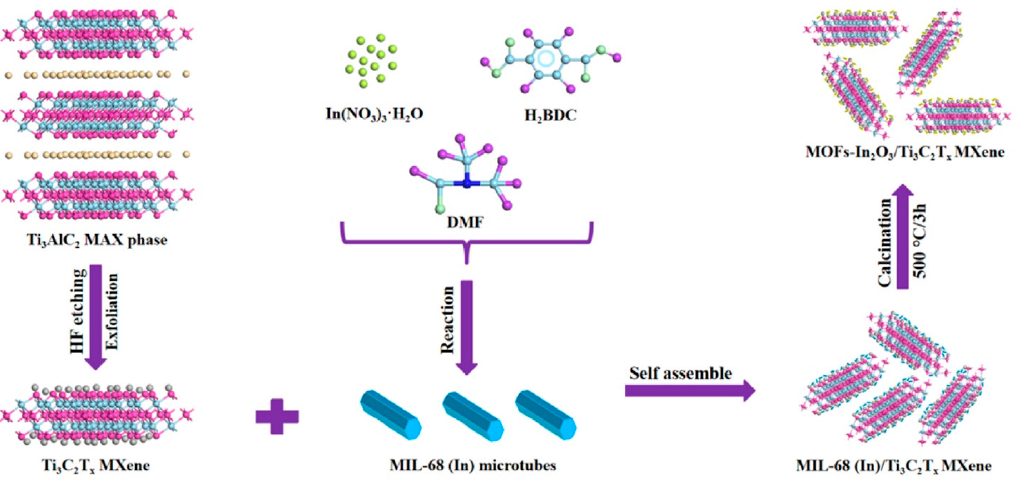
Figure 27. The synthetic illustration of the MOFs–derived In 2 O 3 /Ti 3 C 2 T x MXene composites. Reprinted with permission from [134]. Copyright 2022: Elsevier B.V.